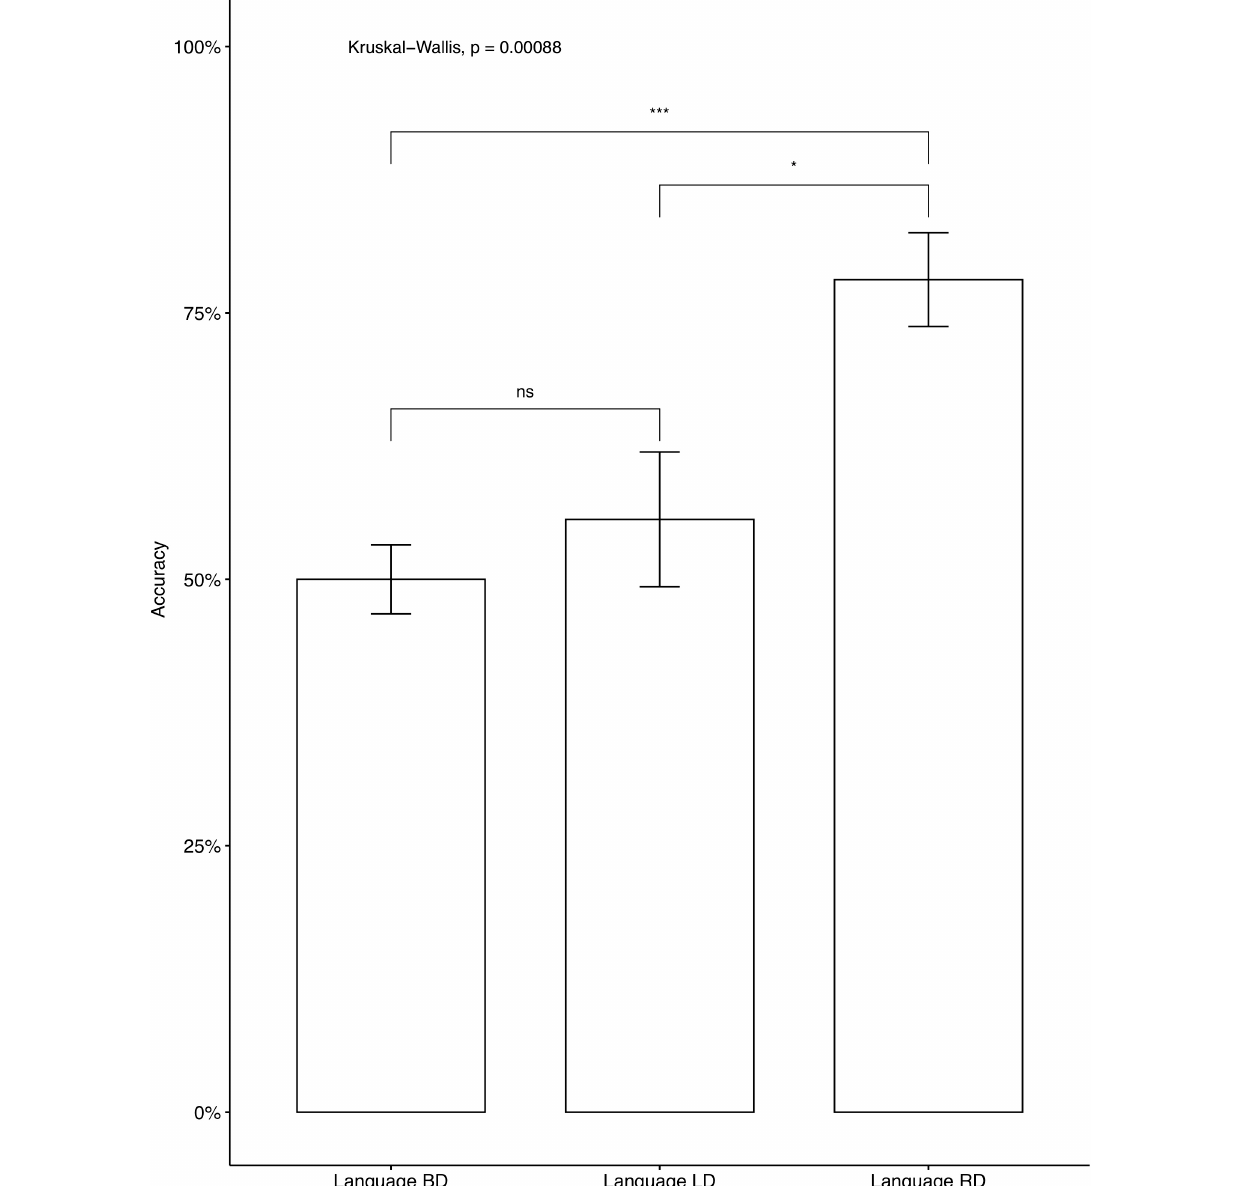
independently for the right-dominant patterns and for the left-dominant patterns. As Figure 4 shows, the accuracy was significantly higher for the right-dominant patterns (54.17%) than left-dominant patterns (38.33%), which further suggests a bias toward right-dominant patterns. The average accuracies on fillers for participants who learned Languages BD, LD, and RD were 70, 80.80, and 83.93%, respectively. 10 Language LD